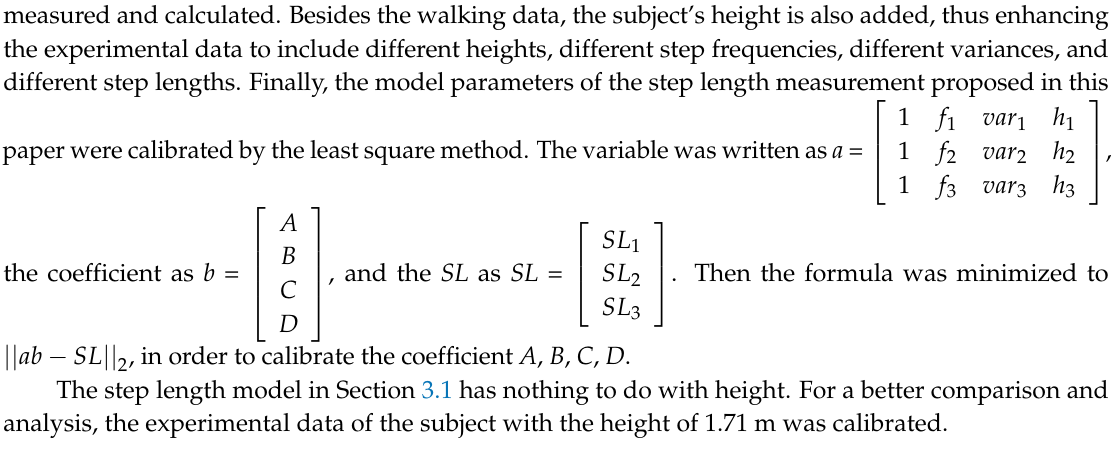
Table 1. The data for parameter